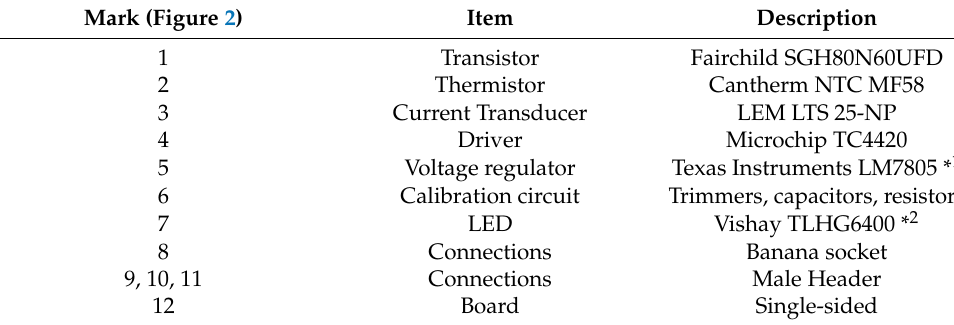
Figure 2. Assembled test model. Table 1. Electronic component list of the test